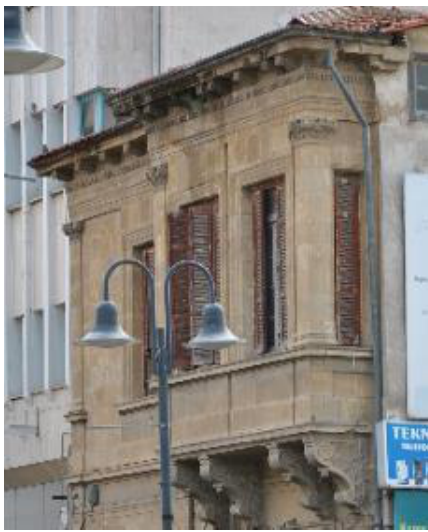
Figur e 18. Decoration in Walled City of Nicosia (Image by Author, 2016).